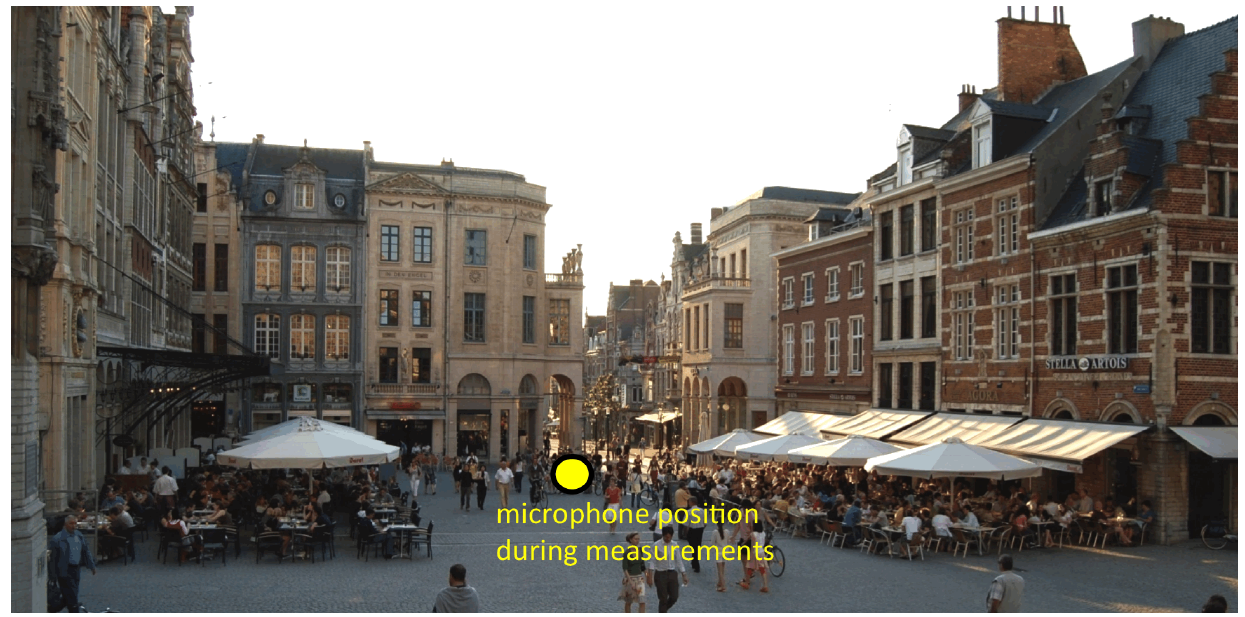
Figure 1. Grote Markt in Leuven, Belgium, view on the part of the square with restaurants with the position of the recording microphone